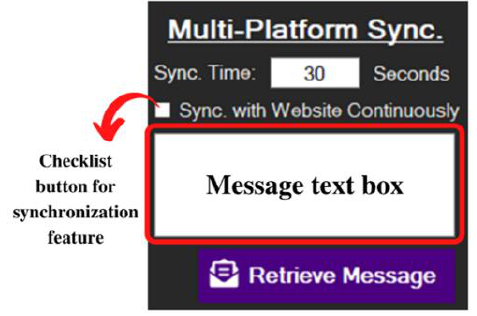
Figure 5. Synchronization settings panel.